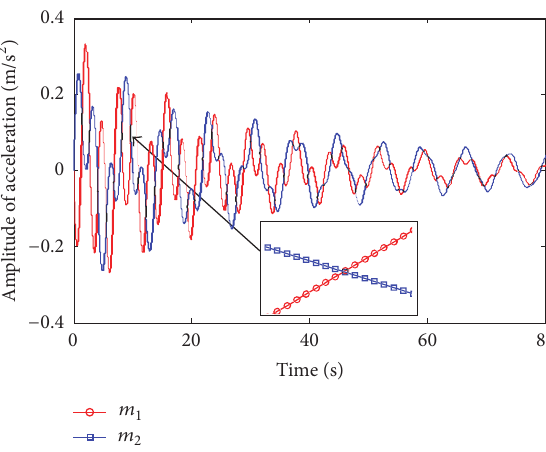
Figure 3: Impact force for simulation.